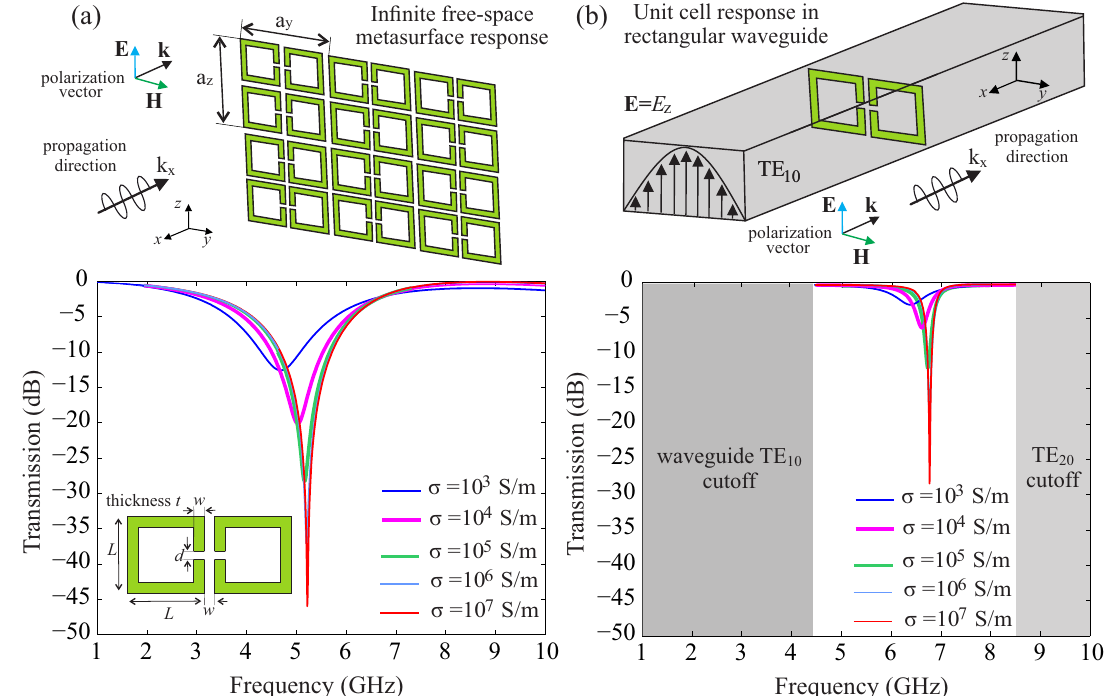
Figure A1. Numerical investigation: ( a ) Transmission spectra from a freestanding free-space, infinite, periodic metasurface, for various electrical conductivities. The side length of the SRR was L = 6 mm, the width of the metallic frames was w = 0.4 mm and the thickness of the metal was t = 0.4 mm. The size of the gap was d = 0.2 mm and the periodicity of the metasurface was a y = 2 ( L + w ) and a z = ( L + w ) along the z and the y axes. The incidence was normal and the polarization was along z axis, E = E z . ( b ) Corresponding transmission spectra of the metasurface placed in a rectangular waveguide. The dimensions of the waveguide are a × b = 35 mm × 15